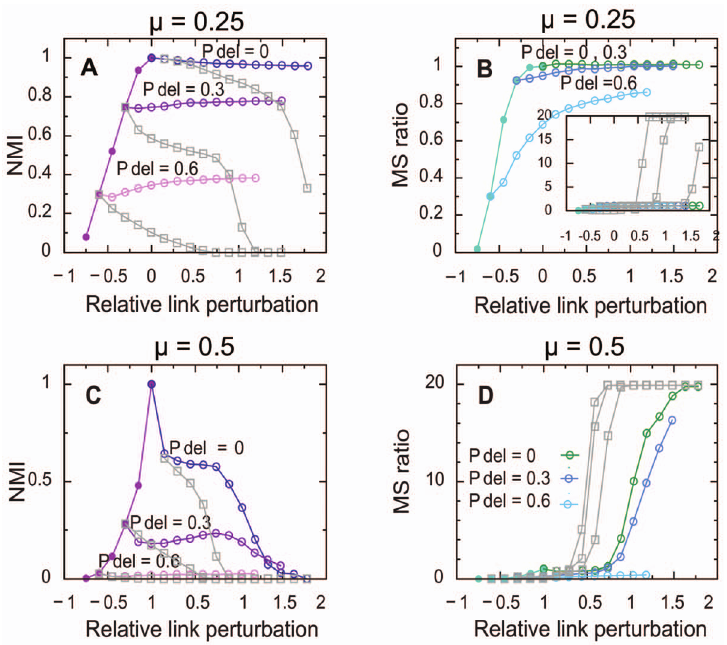
Figure 3. Test of triangle completion on unweighted undirected benchmark networks. The panels show the similarity between the community structure of the original and the perturbed networks as a function of relative link perturbation, in A and B for low module mixing and in C and D for high module mixing. Panels A and C quantifies the similarity in terms of the normalized mutual information (NMI) and panels B and D quantifies the similarity in terms of the module size ratio. Filled circles correspond to the similarity after link removal. Open symbols correspond to the similarity after subsequently adding links by triangle completion (colored circles) and random link addition (gray squares). Link addition starts at 0, 30, and 60 percent link removal. Each point corresponds to an average over 100 networks.